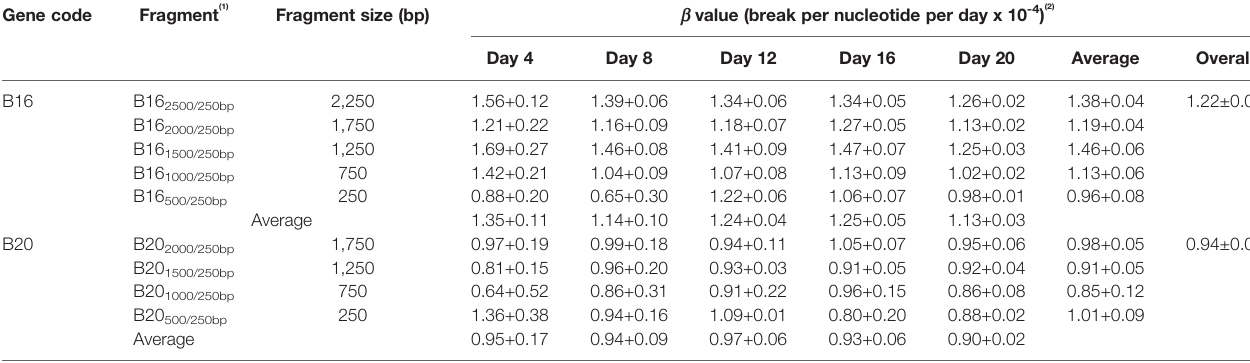
TABLE 1 | Estimated “ b ” values for different fragments at different aging times.